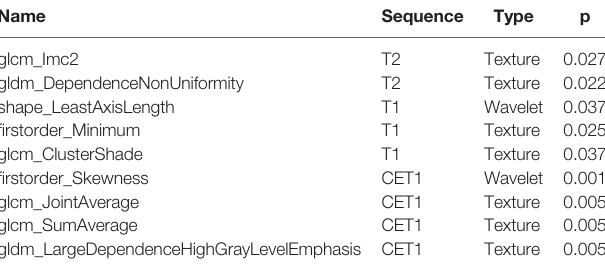
TABLE 2 | The details of selected radiomics